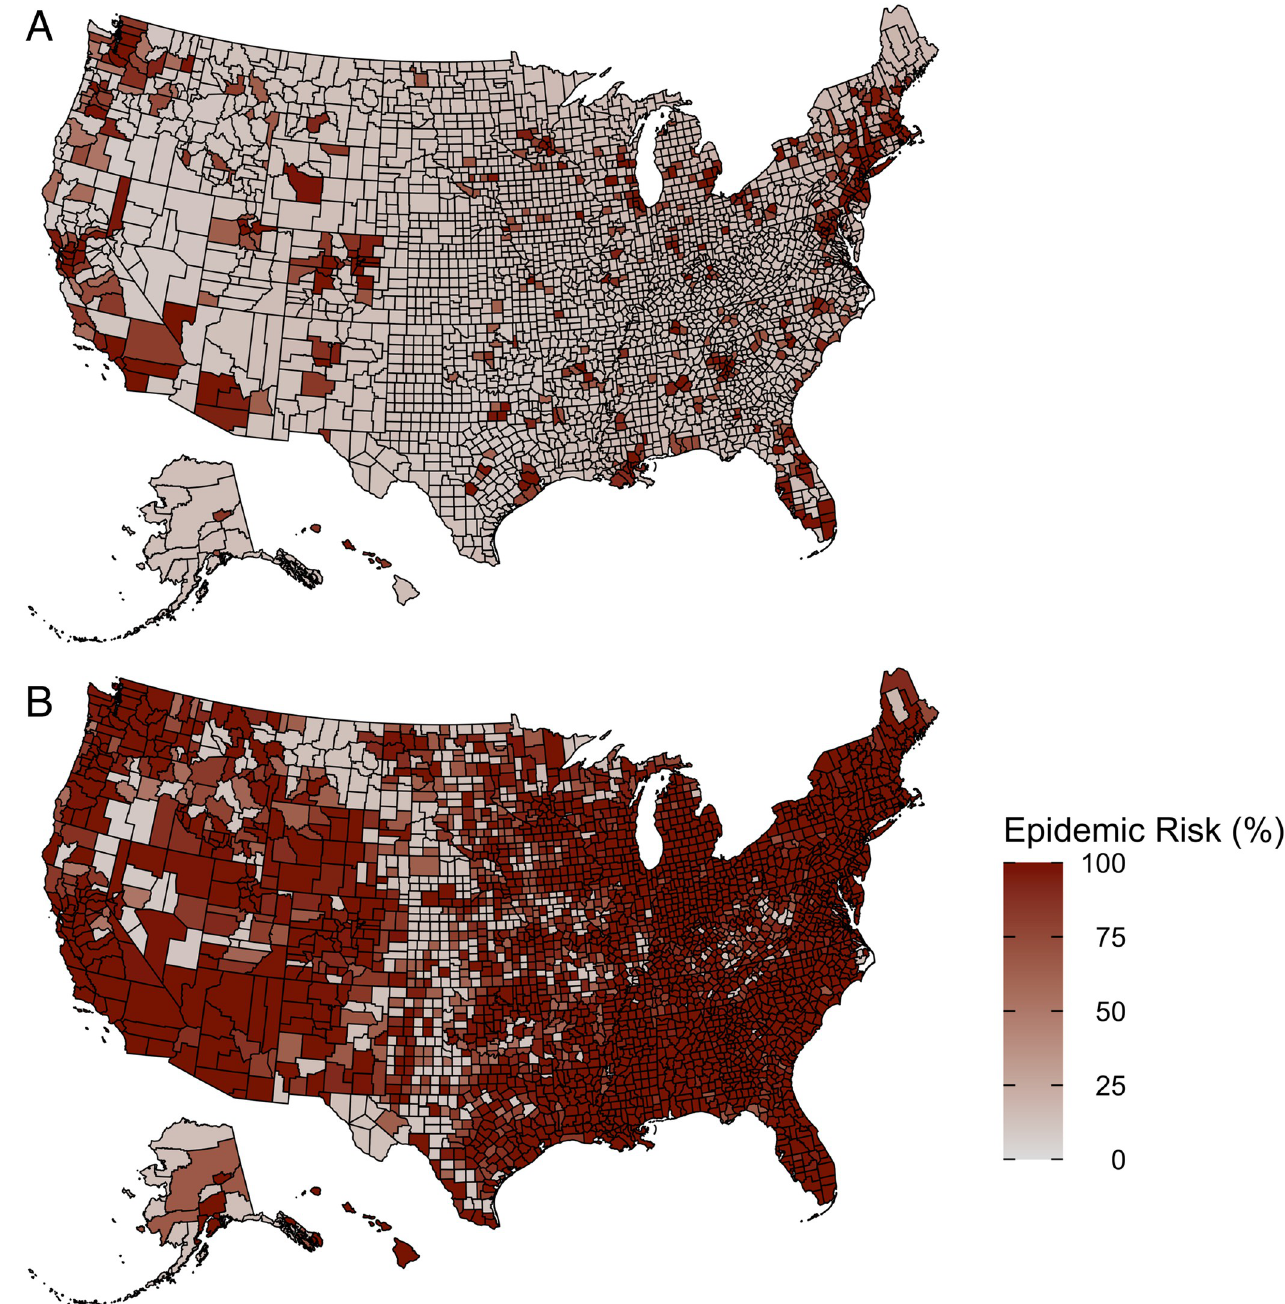
Fig 2. Estimated COVID-19 epidemic risk in 3,142 US counties as of March 16 (A) and April 13, 2020 (B). Epidemic risk was determined for each county based on its effective reproduction number ( R ) as estimated in [7], alongside the number of reported cases in the county on the specific date as described in Fig e 1. Epidemic risk is the percent of 100,000 simulations for the county that become epidemics. We classified a simulation as an epidemic if it reached 2,000 cumulative infections and had a minimum prevalence of 50 new infections per day [5]. County-specific R ranged from 1.4 to 4.4 with a median of 2.8. The e model assumed a 10% case detection rate, generation time of 6.0 days, a latent period of 2.9 days, and infectious period of 6.2 days (Table 1 - retrospective).